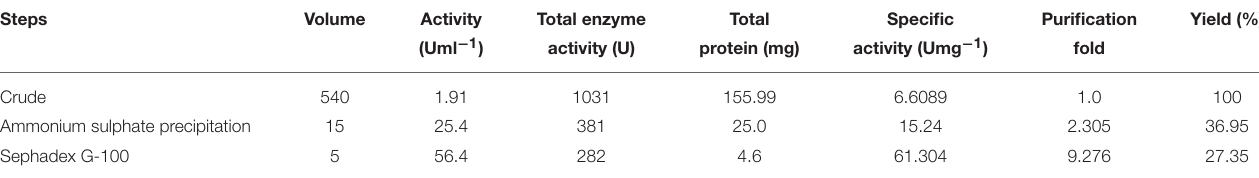
TABLE 6 | Purification summary of isolated amylase. Steps